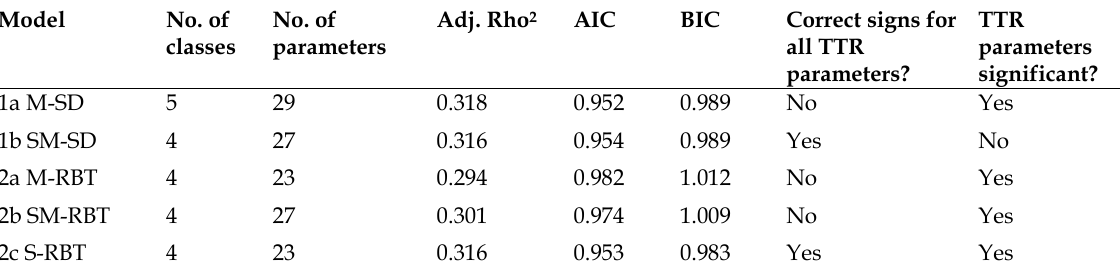
Table 5. Results of latent class model estimations for all model